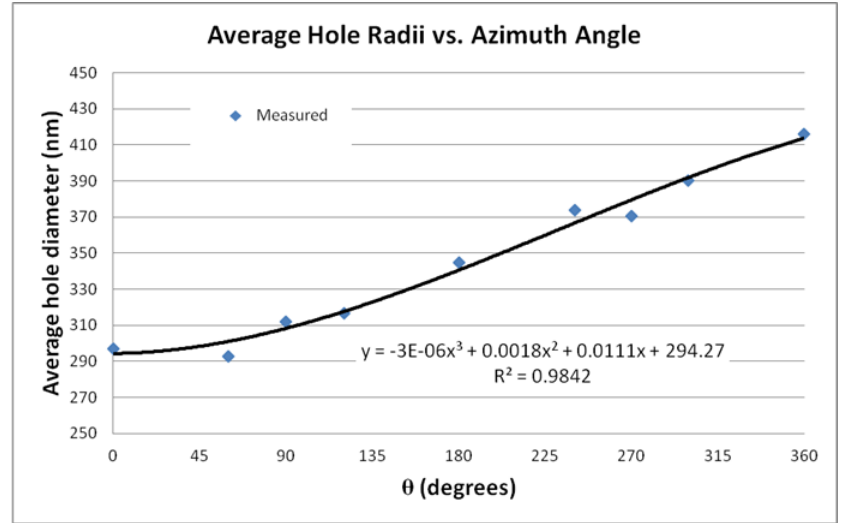
Figure 14. Hole radii variation across the device.